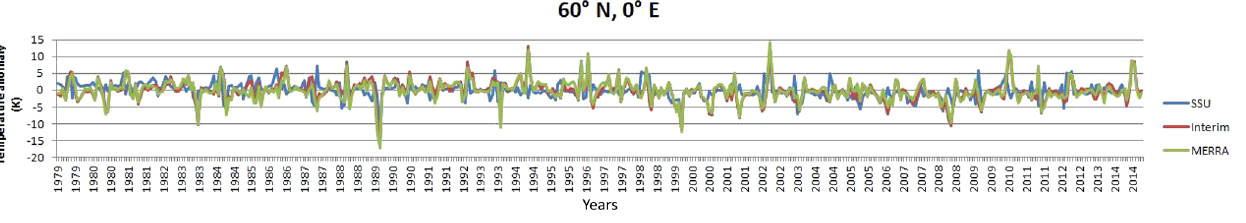
Figure 1. Temperature anomaly time series of MERRA reanalysis (red), ERA-Interim (blue) and SSU (derived by STAR from SSU with AMSU-A, green) for grid point 60 ◦ N and 0 ◦